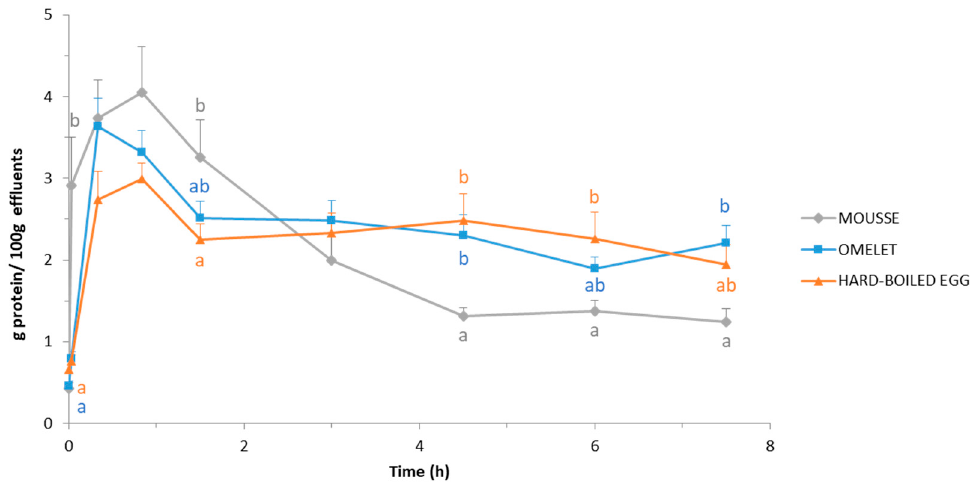
Figure 3. Protein concentration in the duodenal effluents throughout 7.5 h postprandial after the ingestion of the DHA-enriched omelet, hard-boiled egg, and mousse. Concentration is expressed as g protein/100 g effluent. Means and SEM were calculated from n = 9 pigs. For a given digestion time, different letters display significantly different mean values ( p < 0.05).